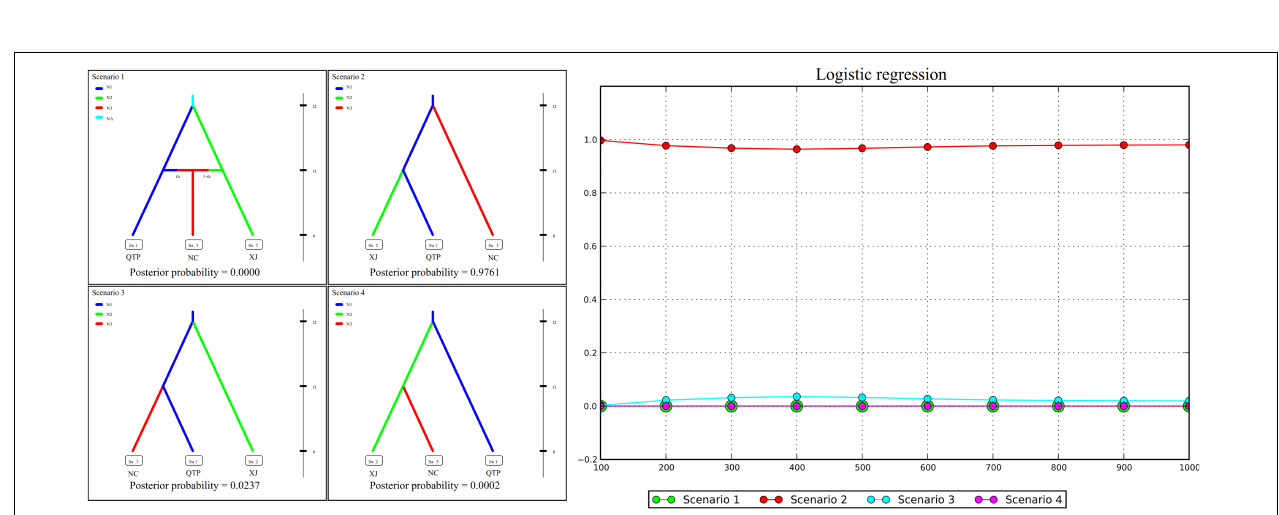
FIGURE 5 | Approximate Bayesian computation (ABC) modeling results of four assumed scenarios and their corresponding posterior probabilities.